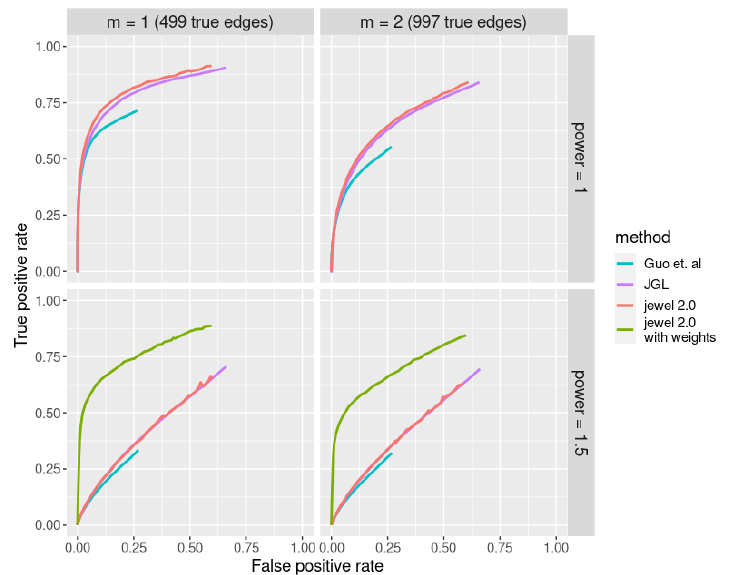
Figure 8. ROC curves corresponding to different joint estimation methods are denoted by different colors. Each panel demonstrates performance in different m − power settings